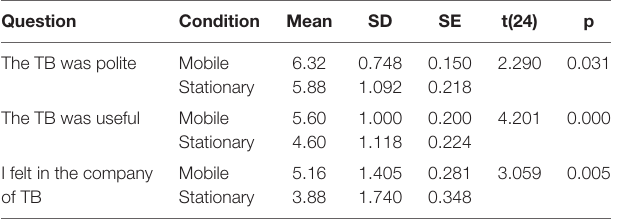
TaBle a2 | Social scale: mobile vs stationary results.